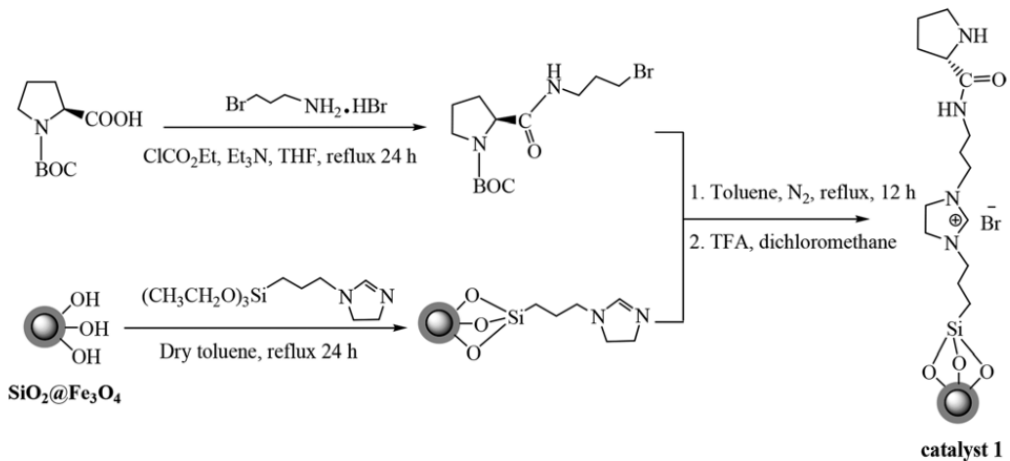
Figure 6. Method for attachment of proline based catalyst to silica coated magnetic nanoparticles. Reproduced from Kong et al. [62], with permission of the Royal Society of